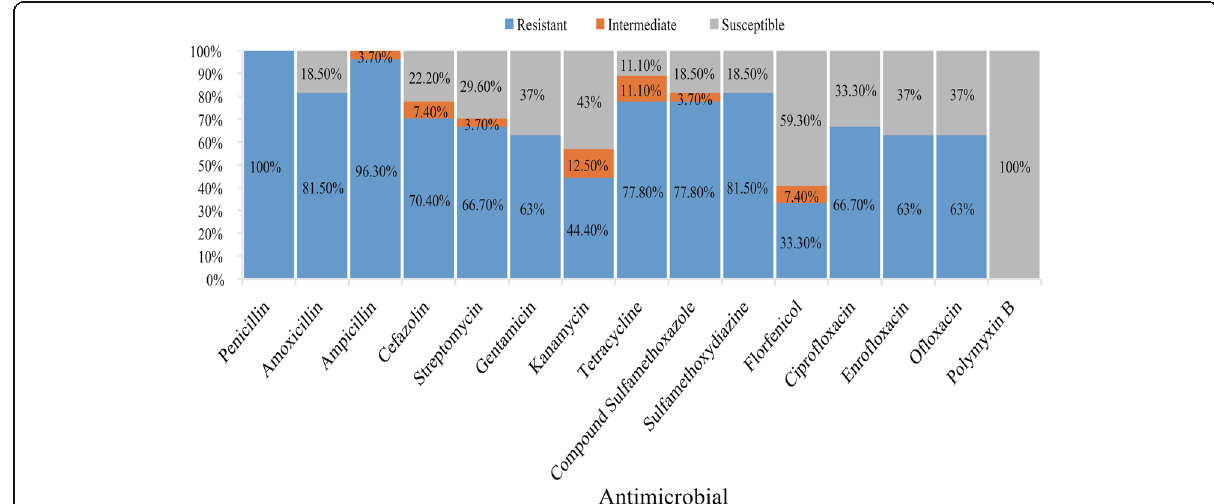
Fig. 1 Antimicrobial susceptibility profile to fifteen antimicrobials of E. coli isolates ( n = 27) from dairy cattle